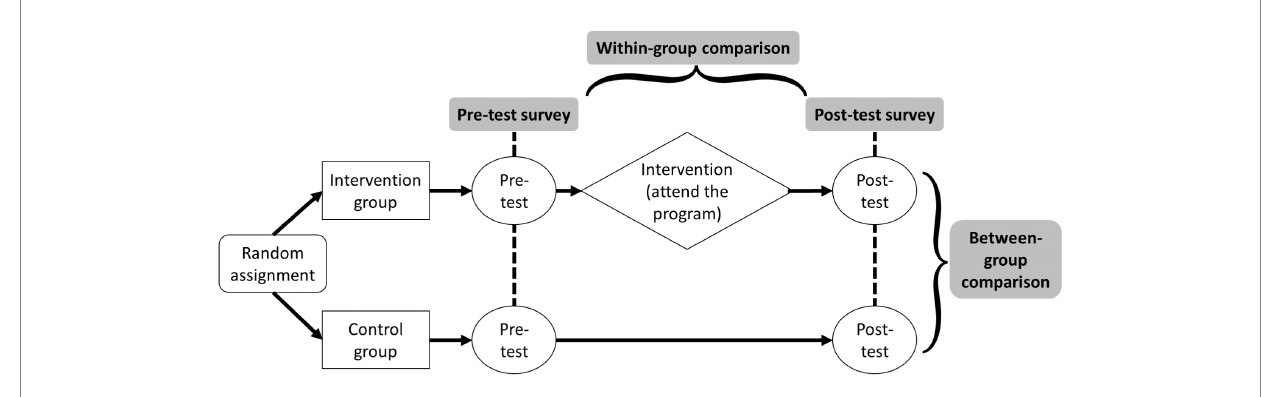
FIGURE 1 Randomized control group pre-test post-test experimental